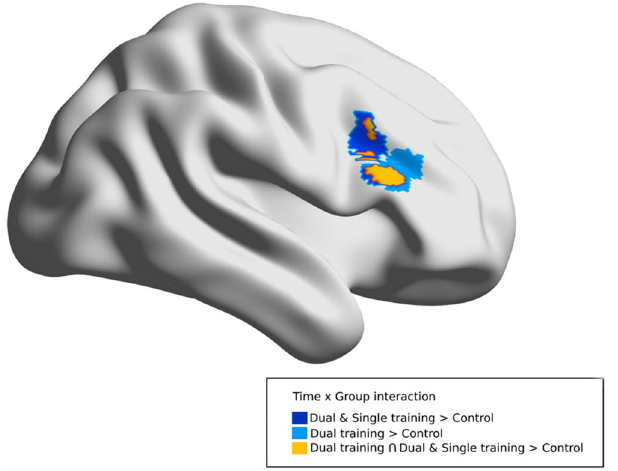
Figure 3. Illustration of the time × group interaction within the ventral DMN. When considering the effect of training (pooling dual and single-task) compared to control group over time, there was an increase in the connectivity over time in the right inferior frontal gyrus (rIFG; in dark blue). To analyze the effect of specific training conditions, a post hoc analysis compared dual-task training versus control group over time and single- training versus control group over time. For dual-task training versus control group, there was an increase in the connectivity in the rIFG (in light blue) overlapping with the results for the pooled training group versus control group (in orange).